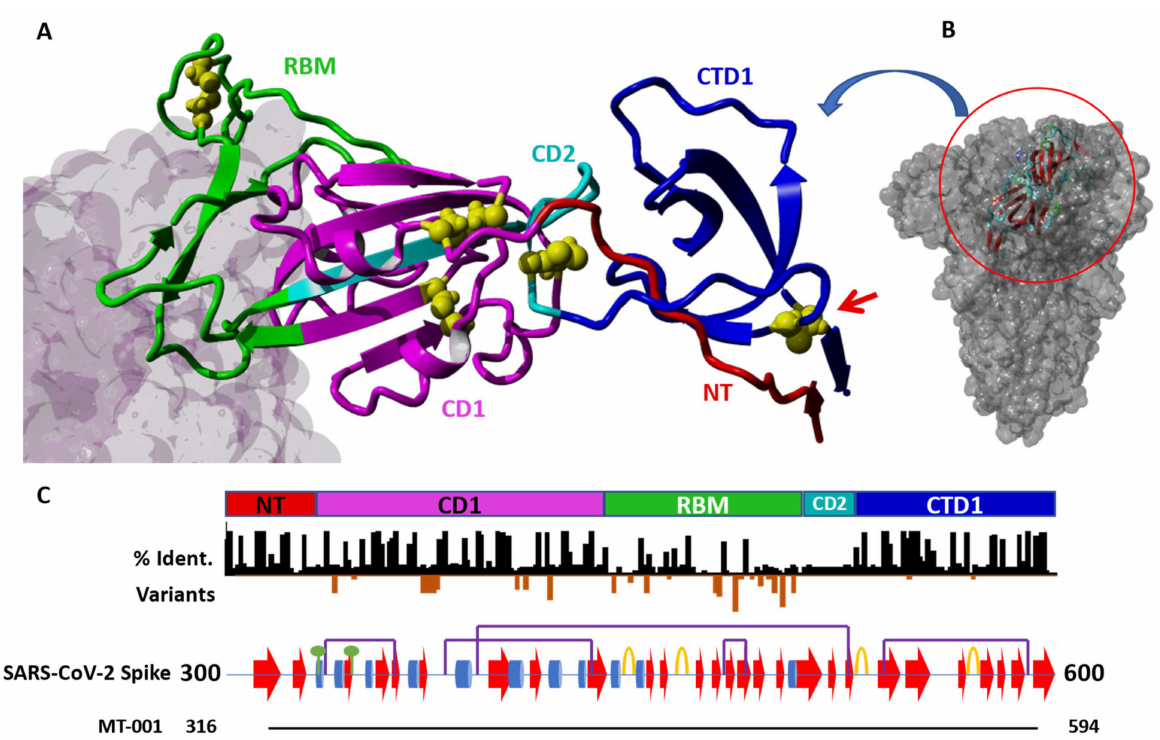
Figure 1. Detail of the SARS-CoV-2 spike protein in the region 300–600 and MT-001 construct design. ( A ) Structure of MT-001 construct derived from PDB IDs 7BYR and 7KNE. The RBD construct is color-coded by annotated blocks of amino acid sequence (“regions”, see panel C and [45]). Cysteines are shown as yellow balls. The cell surface target of the RBM, ACE2 (from 7KNE), is shown as a gray molecular surface (left). ( B ) The MT-001 construct (ribbon) shown in the context of the full-length spike trimer (space-filling model). ( C ) Schematic of the regions shown in (A). Top: Color-coded region key for the MT-001 construct in ( A ). NT: N-terminal region (residues 316–332, red); CD1: “core domain 1” region (333–436, magenta); RBM: receptor binding motif (437–508, green); CD2: “core domain 2” region (509–527, cyan); CTD1: “C-terminal domain 1” region (528–594, blue). The 538–590 disulfide bond that stabilizes CTD1 is indicated by a red arrow. Middle: Black bars—Sequence identity per residue between SARS-CoV-2 spike and representative members of the coronavirus superfamily, demonstrating highly conserved regions N- and C-terminal to the RBM (Table S1). Orange bars—Sites of and frequency of mutations in characterized SARS-CoV-2 variants [3]. Lower: Schematic showing the secondary structure and post-translational modifications in the region from residues 300–600 in the SARS-CoV-2 spike protein. Alpha helices are shown as blue cylinders, beta sheets as red arrows, and turns as orange loops. Disulfide bonds are denoted with purple bridges, and N-linked glycosylation sites are denoted with green circles. Bottom: Alignment of the MT-001 construct with the visualized